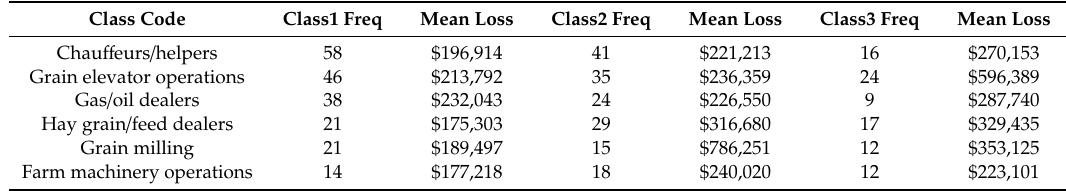
Table 8. Frequency and severity of claims based on latent class analysis (LCA)